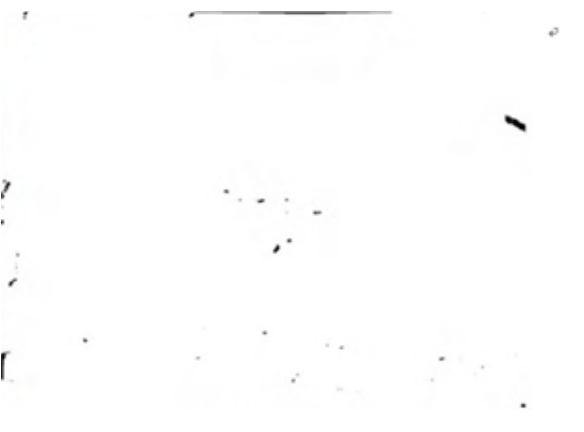
Figure 5: The effect of improving the use of image fusion algorithm